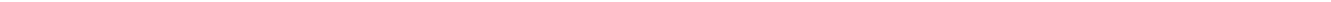
Fig. 4 Txnrd1 -de fi cient T cells have a proliferation defect independent of ROS. Magnetically sorted T cells from spleen and peripheral LNs of Txnrd1 fl / fl and Txnrd1 fl / fl ; Cd4-Cre mice were stimulated in α CD3/CD28-coated plates. a , b Shown are the expression levels of c-Myc ( a ), Txn1 and Txnrd1 ( b ) determined by RT-PCR in CD4 + T cells ( n = 3 – 4). c Normalized copy numbers of Txn1 and Grx1 determined by RT-PCR. The obtained Ct values were converted to DNA concentration using a standard curve ( n = 3 – 4). d Expression level of Txnip determined by RT-PCR in CD4 + T cells ( n = 3 – 4). e c-Myc (left) and CD71 (right) protein expression levels measured by fl ow cytometry after incubation of stimulating CD4 + T cells with the indicated concentrations of the c-Myc inhibitor ( + )-JQ1 for 10 h. f Txnip expression levels in CD4 + T cells stimulated in the presence of the indicated concentrations of ( + )-JQ1 ( n = 3). g T cell counts at indicated times ( n = 2). h CFSE dilution of CD8 + T cells measured by fl ow cytometry at the indicated times of stimulation. i CFSE-dilution pro fi les were used to calculate mean division time ( t division ; reciprocal of the slope) and time to fi rst division ( t 1°division ; intersection with mean division number y = 1) with the precursor cohort method. j CD8 + T cells leaving G 0 phase and entering cell cycle were detected by staining for Ki-67 at the indicated times of α CD3/CD28 stimulation. Numbers in the plots indicate average percentage of Ki-67 + cells from triplicate samples. k CD8 + T cells were treated with the antioxidants ascorbic acid (0.8, 4, 20 μ M), Catalase-polyethylene glycol (catalase; 278, 1136, 4545 U/ml), Diphenyleneiodonium chloride (DPI; 62.5, 250, 1000 nM), DL -Dithiothreitol (DTT; 111, 333, 1000 μ M) and N- acetyl- L -cysteine (NAC; 2, 8, 32 mM) during stimulation and counted after 3 days ( n = 4). l Expression of indicated activation markers in CD8 + T cells measured by fl ow cytometry during the fi rst 8 h of stimulation ( n = 3). Dots and bar graphs are mean ± standard deviation. Data are representative of two ( a – g , k , l ), fi ve ( h ) and three ( i, j ) independent experiments. One-way ANOVA followed by Dunnett ’ s correction was used in a , b , d : ** P ≤ 0.0021; **** P ≤ 0.0001. Student ’ s t test (two-tailed, unpaired) was used in c , g : * P ≤ 0.05; ** P ≤ 0.01; *** P ≤ 0.001; **** P ≤ 0.0001. One-way ANOVA adjusted by Tukey ’ s multiple comparison test was used in f : **** P ≤ 0.0001; ns not signi fi